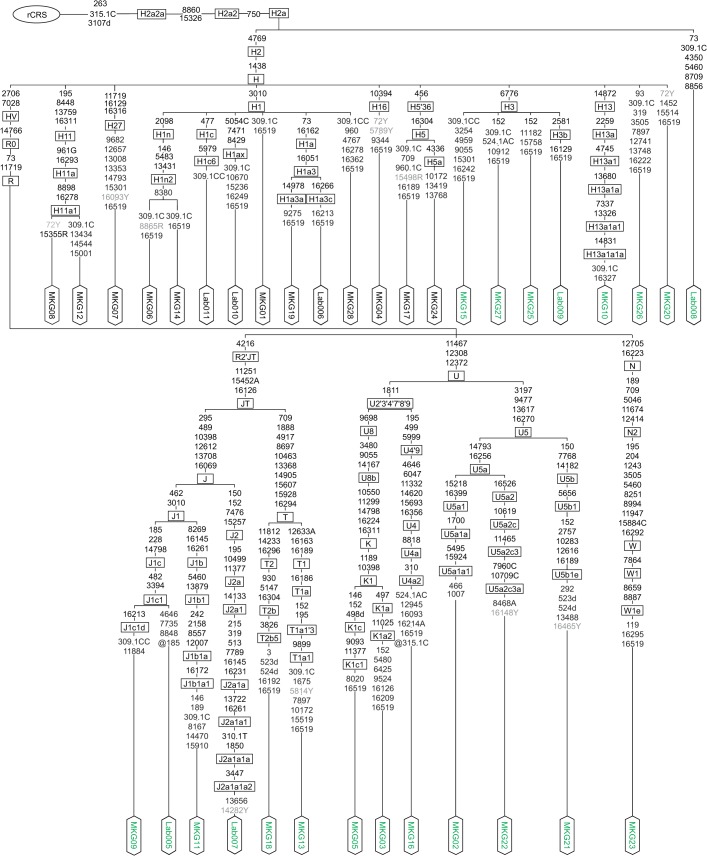
Phylogenetic tree representing the benign profiles of 28 oral cancer patients and seven team members.The sequences are stored in GenBank (accession numbers KC286583 –KC286589 corresponding to Lab005 –Lab011 and KC286590 –KC286617 corresponding to MKG01 –MKG28). The position of the rCRS is indicated for reading off sequence motifs. Mutations are transitions unless a base is explicitly indicated. The prefix ‘‘@” designates reversions, whereas suffixes indicate transversions (to A, G, C, or T), indels (.1, d), and heteroplasmies (R, Y). Point heteroplasmic mutations that were observed in benign tissue samples are highlighted in grey.